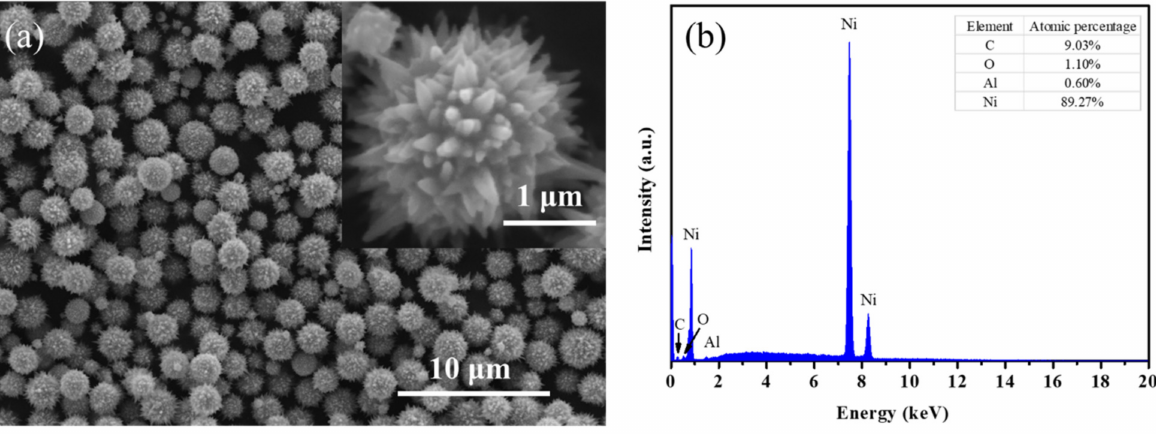
Figure 2. The SEM image ( a ) and EDS pattern ( b ) of the as-prepared urchin-like Ni particles.